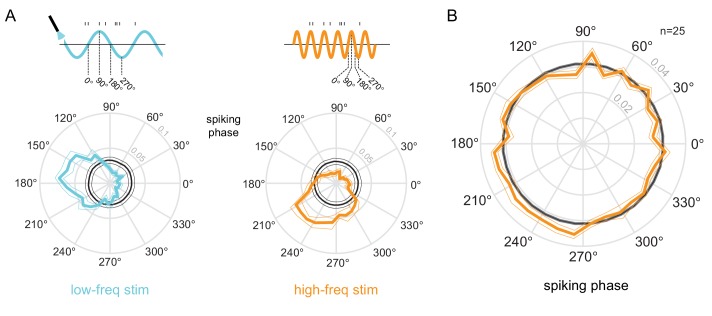
Phase-locking to optical stimulation.(A) Phase plots for an example unit showing the distribution of spiking activity with respect to the phase of the low-frequency (5Hz, left) and high-frequency (20Hz, right) optical stimulation. In gray is the null distribution obtained from a rate-matched Poisson process. The unit shows significant deviations from the null distribution, indicative of phase locking to both stimulations (p≪0.01 for both stimulation conditions, Rayleigh test). (B) Population phase-locking plot illustrating the bias in spiking activity to the high-frequency optical stimulation (n=25). Same convention as in (A).